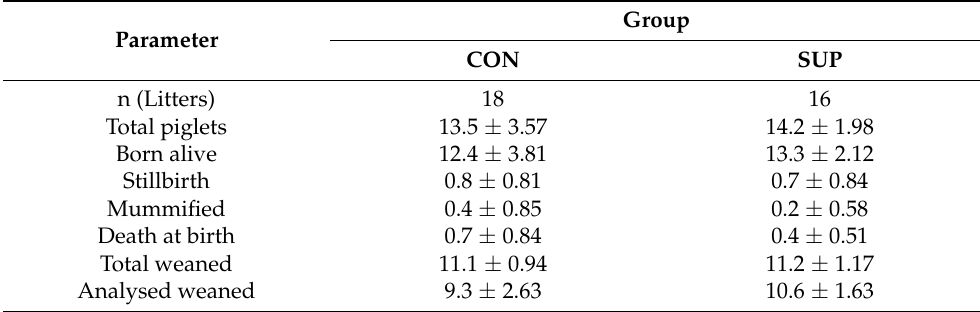
Table 1. Reproductive parameters of the gilts from both groups (raw data). Data